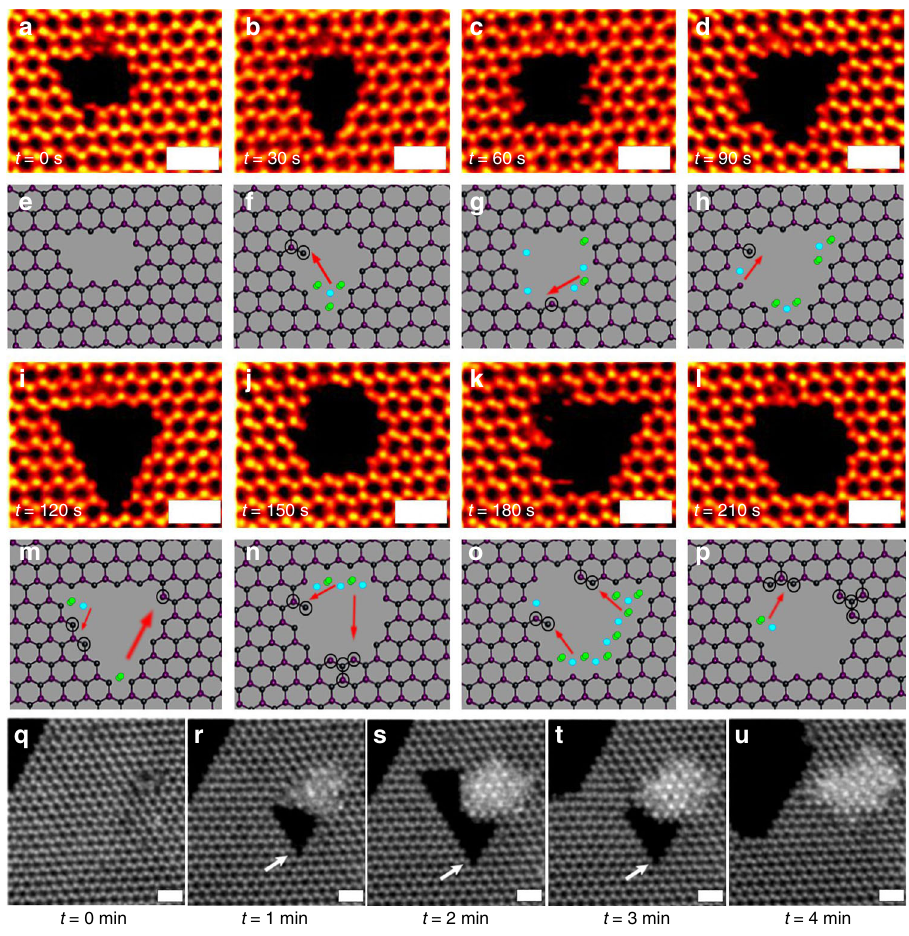
Fig. 8 Nanopore geometric reconstructions. a – p Time series of ADF-STEM images, and their corresponding atomic models. Holes can be seen to change its shape in monolayer PbI 2 fl ake. The blue atoms correspond the lead defect region and the green corresponds to the iodide defect region. The black circles around the atoms in the atomic models correspond to the new atomic bond in the structure as compared from the previous frame. q – u Time series of ADF- STEM images recorded after every 1 min of electron beam exposure. The defect starts forming after 1 min, in image r and more atoms are ejected to form a bigger defect in s . Then the atoms at the edge starts ejecting out in t and reconstruction of the fl ake starts occurring leading to again defect-free surface in u .The scale bar in all images corresponds to 1